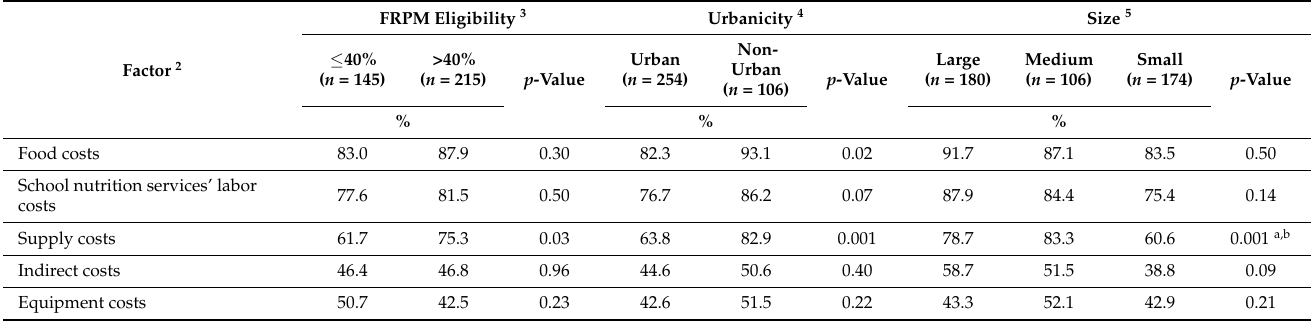
Table 5. Main factors reported in driving the foodservice deficit in the SY 2021–22 using the select characteristics noted by the Californian school food authorities ( n = 271) 1